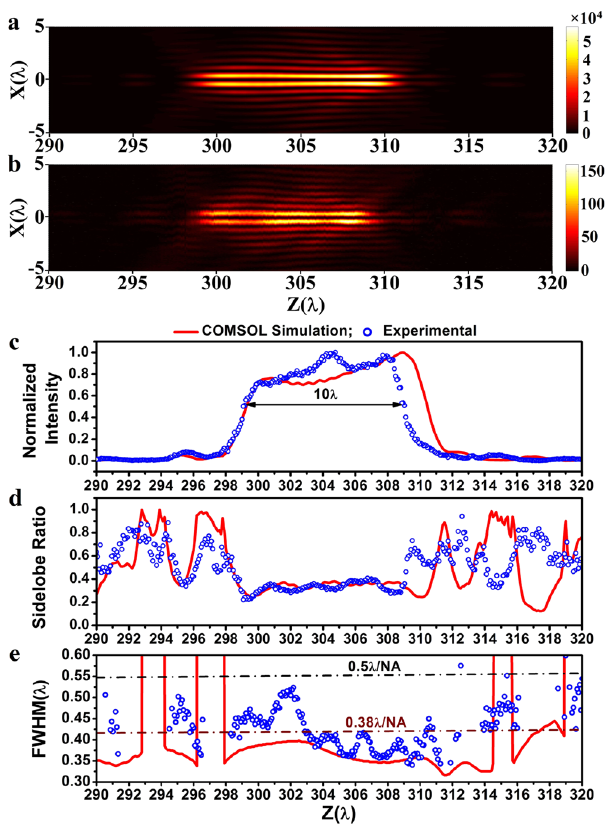
Figure 8. Comparison between COMSOL numerical simulation and experimental results, where the optical intensity, sidelobe ratio, and FWHM are given in arbitrary unit, ratio value, and λ respectively. ( a ) simulation and ( b ) experimental results of the 2-dimentional optical intensity distribution in the XZ propagation plane; ( c ) the normalized central ring peak intensity, ( d ) the sidelobe ratio, and ( e ) the transverse average FWHM distributions along the propagation direction. The black arrow indicated the 10- λ longitudinal FWHM of the experimentally obtained hollow needle. The black and wine-colored dashed-dotted lines indicate the diffraction limit (i.e., 0.5 λ /NA) and super-oscillatory criterion (i.e., 0.38 λ /NA),